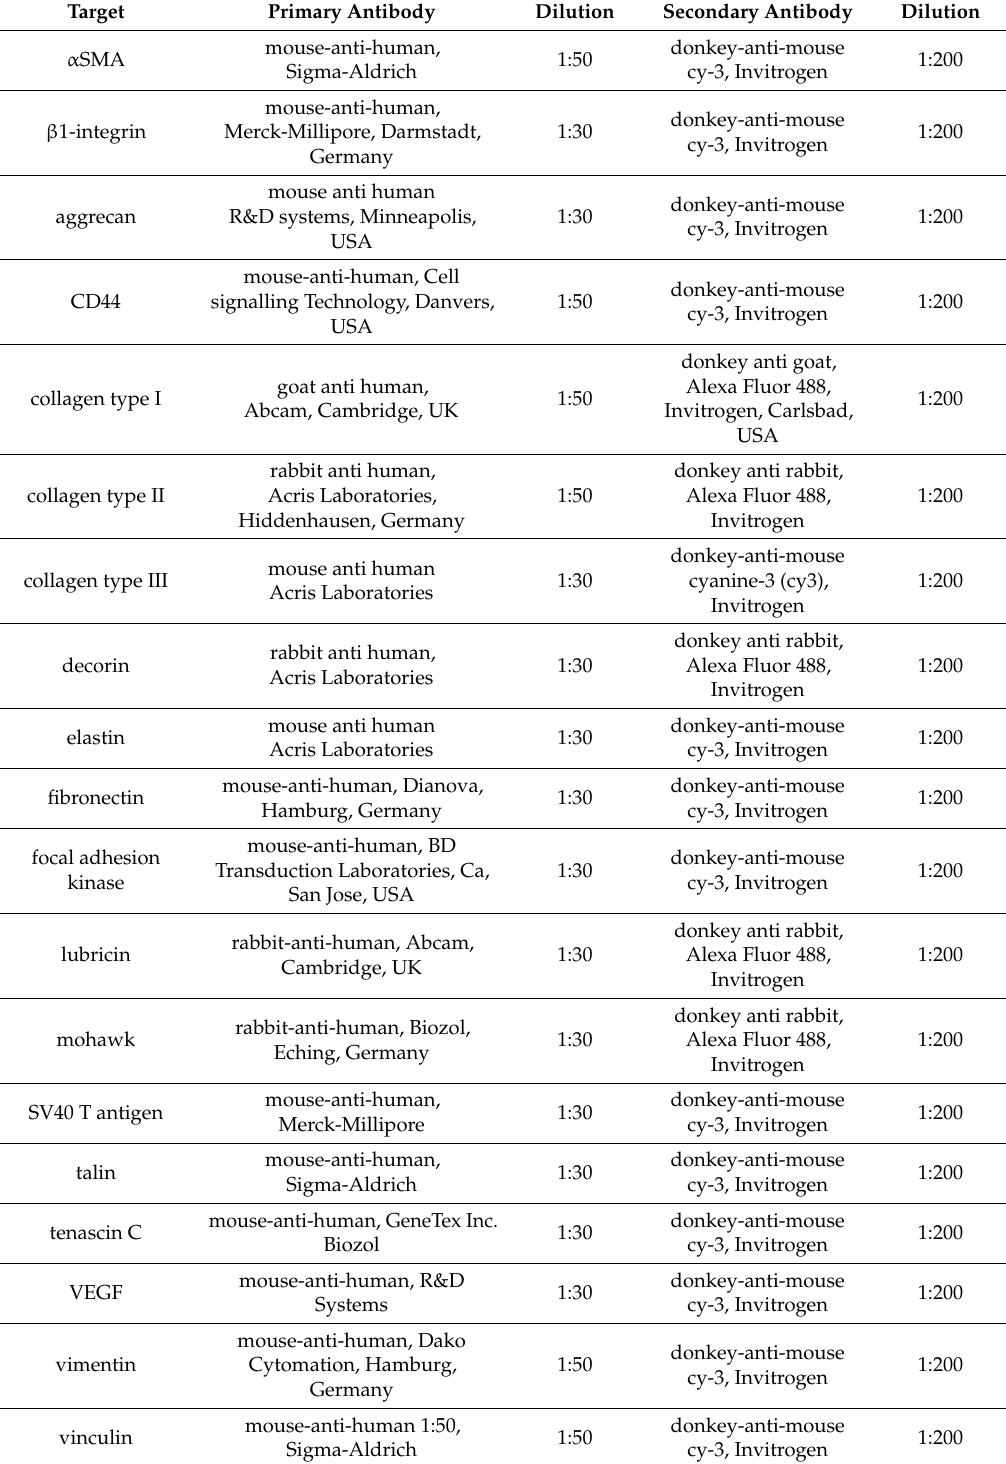
Table 1. Antibodies used for